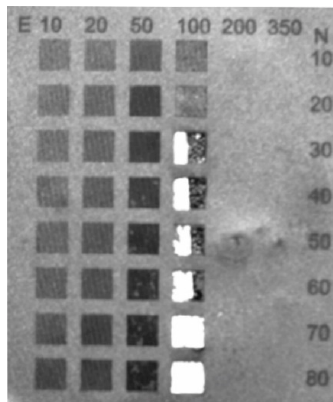
Figure 3. View of the specimens after laser ablation. E—pulse energy in μ J; N — number of laser pulses.